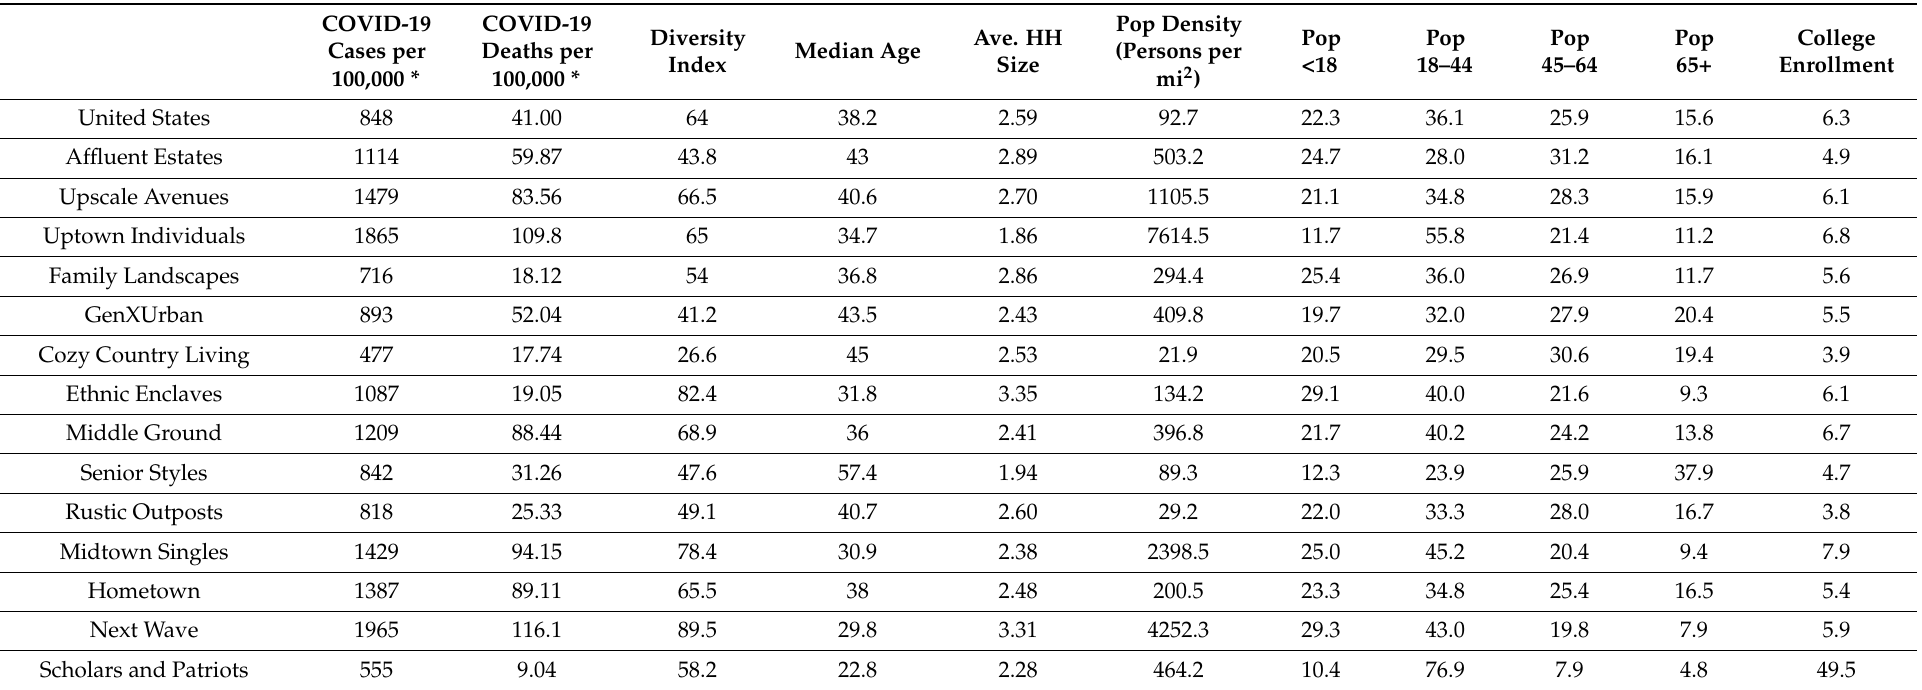
Table 5. Demographic profile of LifeModes in comparison to overall U.S